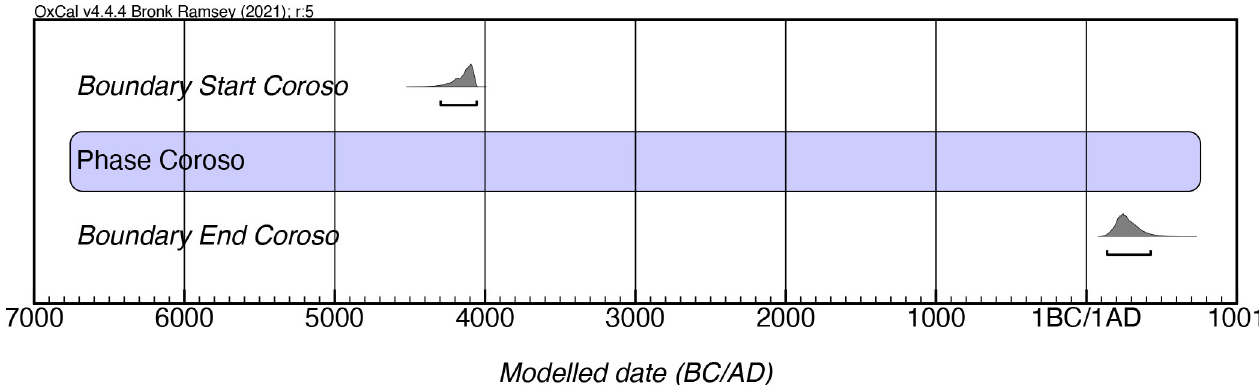
Fig 5. Modeled date ranges for the Coroso style in Puerto Rico. Probability distributions indicate modeled 2 σ (95.4%) confidence intervals for beginning and end of phase.